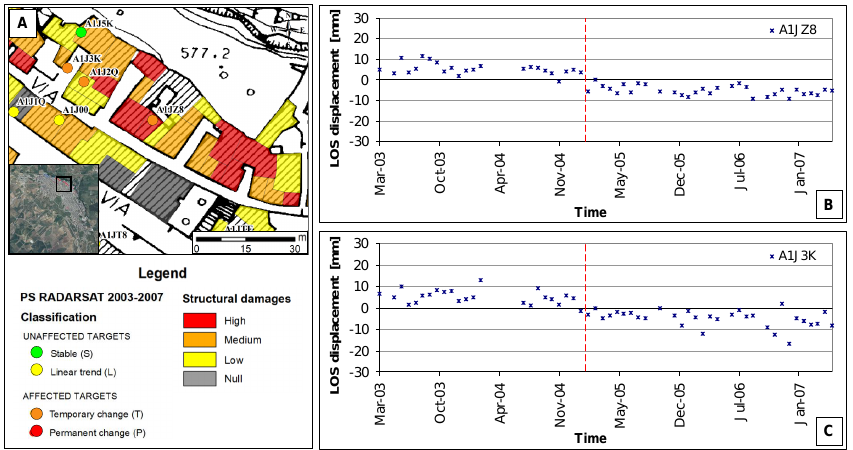
Fig. 14. (A) : Comparison of PS deformation behaviours with structural damage mapped on the buildings in the framework of RiscMass project (Basile and Cocina, 2006), overlapped on a 1:2000 topographic map: inset on some buildings located in Vanelle St. (historic area). B , C : Example of PS time series for buildings affected by structural damages of high or medium level. Their trends underwent some temporary changes (T pattern, see Fig. 2) that are probably related to the ground displacements occurred on 4 February 2005 (red dashed line). PS displacements are measured along RADARSAT-1 (2003–2007) LOS in ascending